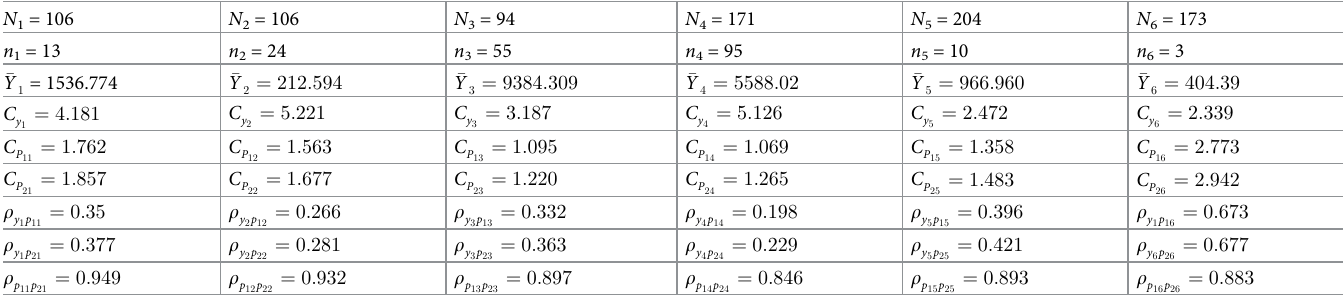
Table 5. Summary statistics of population